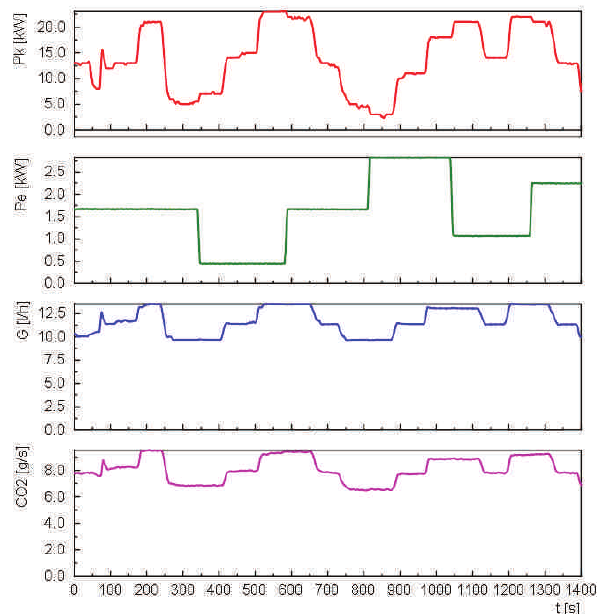
Fig. 4. Research results for the measurement point defined by n = 1,165 rpm, M n = 0.1, P = 14 kW